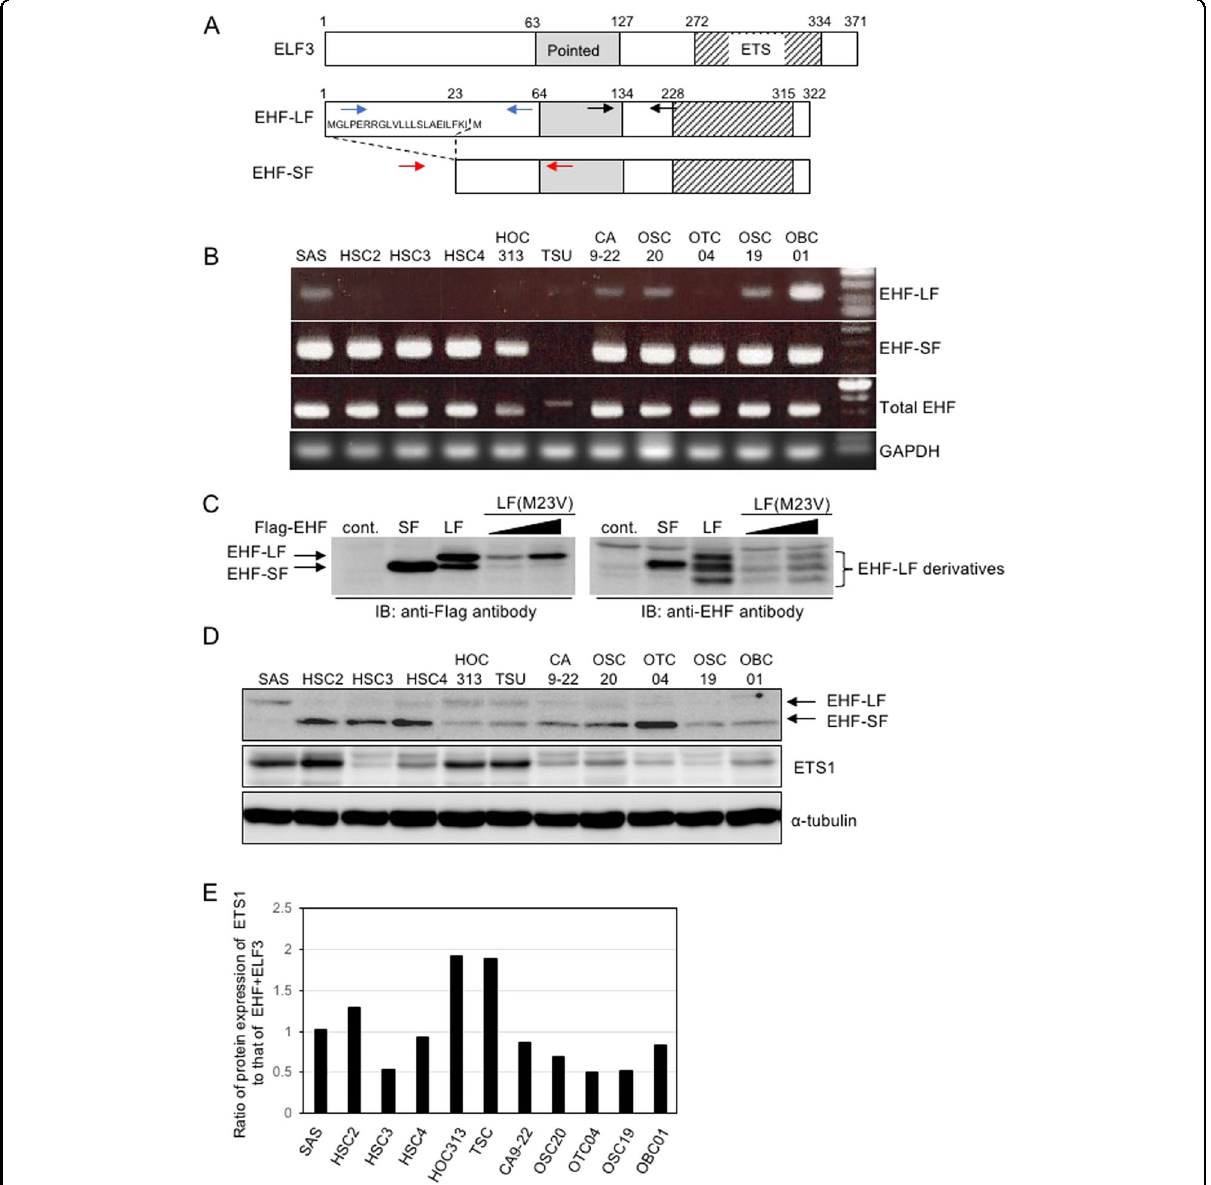
Fig. 2 Two variants of EHF. A Schematic illustration of ELF3 and EHF gene products is shown. The long form variant of EHF includes 22 amino acid residues from exon 1 ( EHF-LF ), whereas the short form variant of EHF excludes exon 1 (EHF-SF). The pointed and ETS domains are shown as grey and hatched areas, respectively. The primers used to amplify EHF-LF , EHF-SF , and total EHF are shown in blue, red, and black arrows, respectively. B mRNA levels of two EHF transcript variants were analyzed by conventional RT-PCR. C and D IB with the indicated antibodies were performed in COS7 transfected with control vector (cont.) or the indicated plasmids ( C ), and in HNSCC cells ( D ). E ETS1 ( D ), EHF-SF ( D ), and ELF3 (S2B) protein levels were densitometrically quanti fi ed and compared with those of α -tubulin. The ratio of protein expression of ETS1/ α -tubulin to that of EHF-SF/ α -tubulin + ELF3/ α -tubulin in SAS cells was indicated as “ 1 ” . α -tubulin was used as a loading control ( D ). EHF-LF(M23V), a mutant in which Met 23 in EHF-LF was substituted with Val ( C